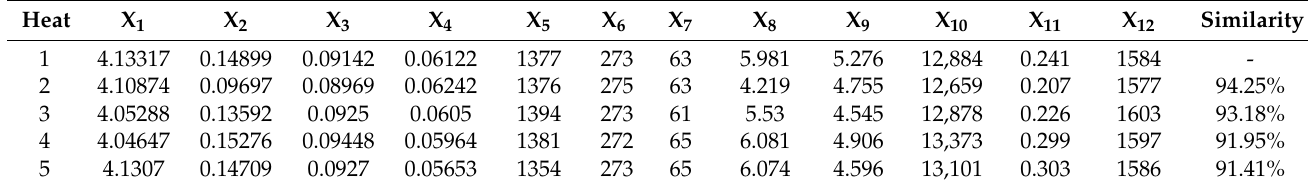
Table 3. The similarity between the new case and the similarity